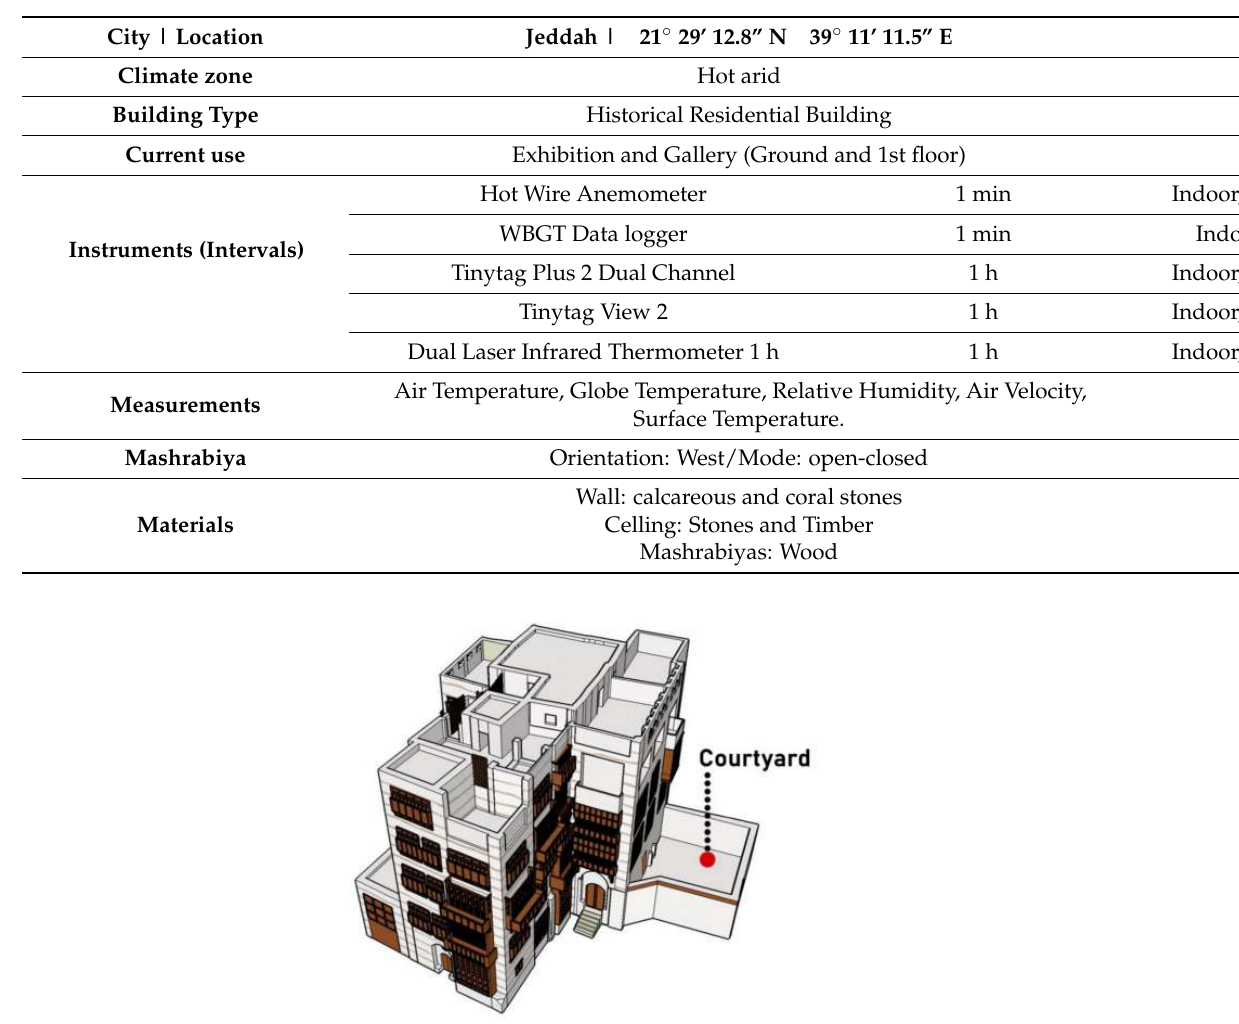
Table 3. Overview of the building and measurement equipment.